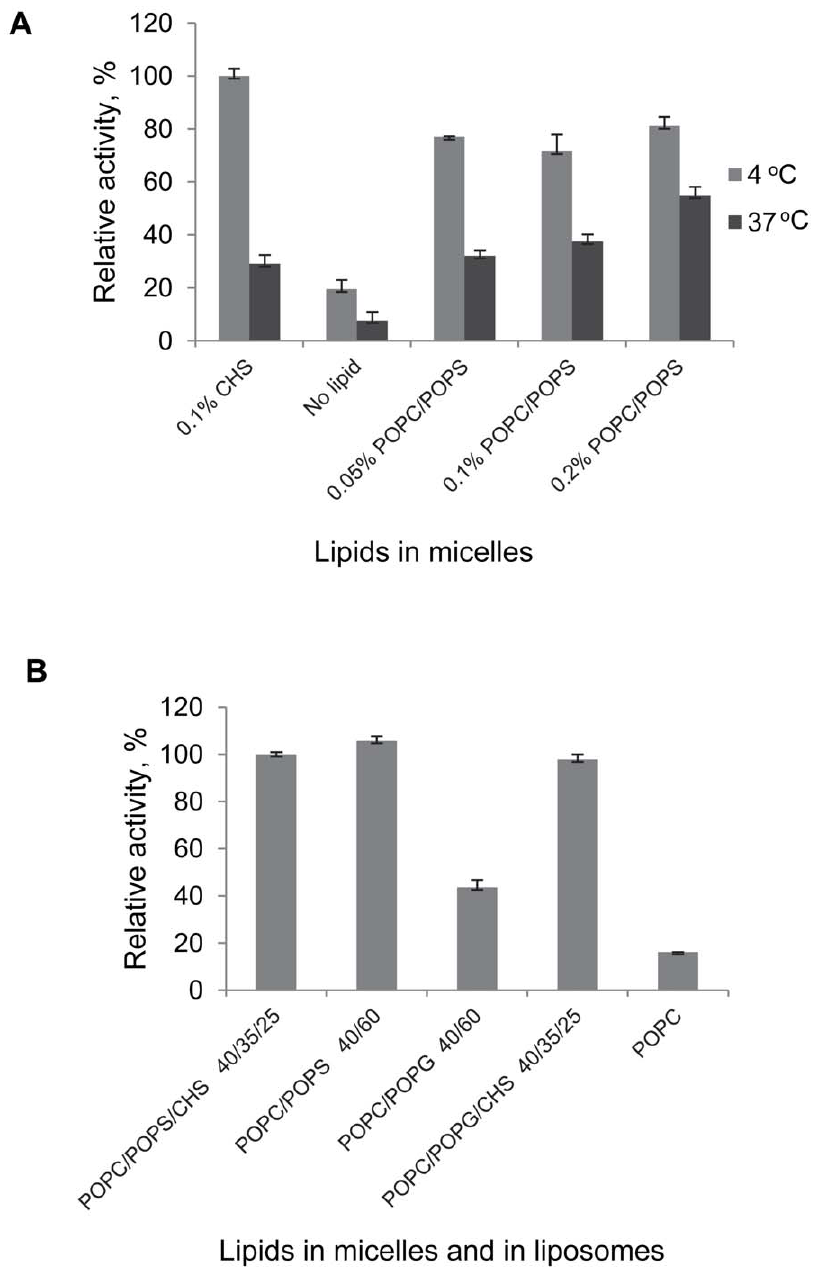
Figure 10. Stabilizing effects of POPC:POPS (1:1, w/w) in micelles. A, Lipids were added to DDM/CHAPS (0.1%/0.5%) micelles at concentrations indicated. Upon incubation samples were supplemented with POPC:POPS dissolved in 1% CHAPS so that the final protein-to-lipid ratio was the same in all samples (1:500 mol/mol). Upon reconstitution on a mini-spin detergent-absorbent columns the activity of CB 2 was determined by the G protein activation assay and reported as % of the maximal activity measured for this series of samples. The liposomes- reconstituted receptor (0.1% CHS in micelles, POPC/POPS/CHS 60:15:25 in liposomes) exhibiting the highest levels of activation in this experiment was used as an activity standard. B, Purified CB 2 in DDM/CHAPS/CHS micelles was captured on Ni-NTA, detergent buffer rapidly exchanged to DDM/ CHAPS containing 0.4% of lipids of indicated composition, protein eluted with imidazole and liposome-reconstituted by rapid dilution. Functional activity of CB 2 reconstituted into POPC/POPS/CHS matrix is set as 100% of activity. Figures depict data 6 SD (error bars) of duplicate determinations from representative experiments (n=2-3).